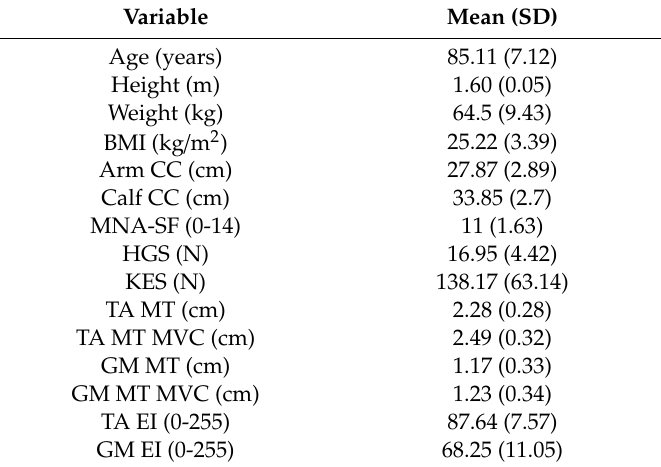
Table 1. Physical, nutritional and muscle ultrasound characteristics.